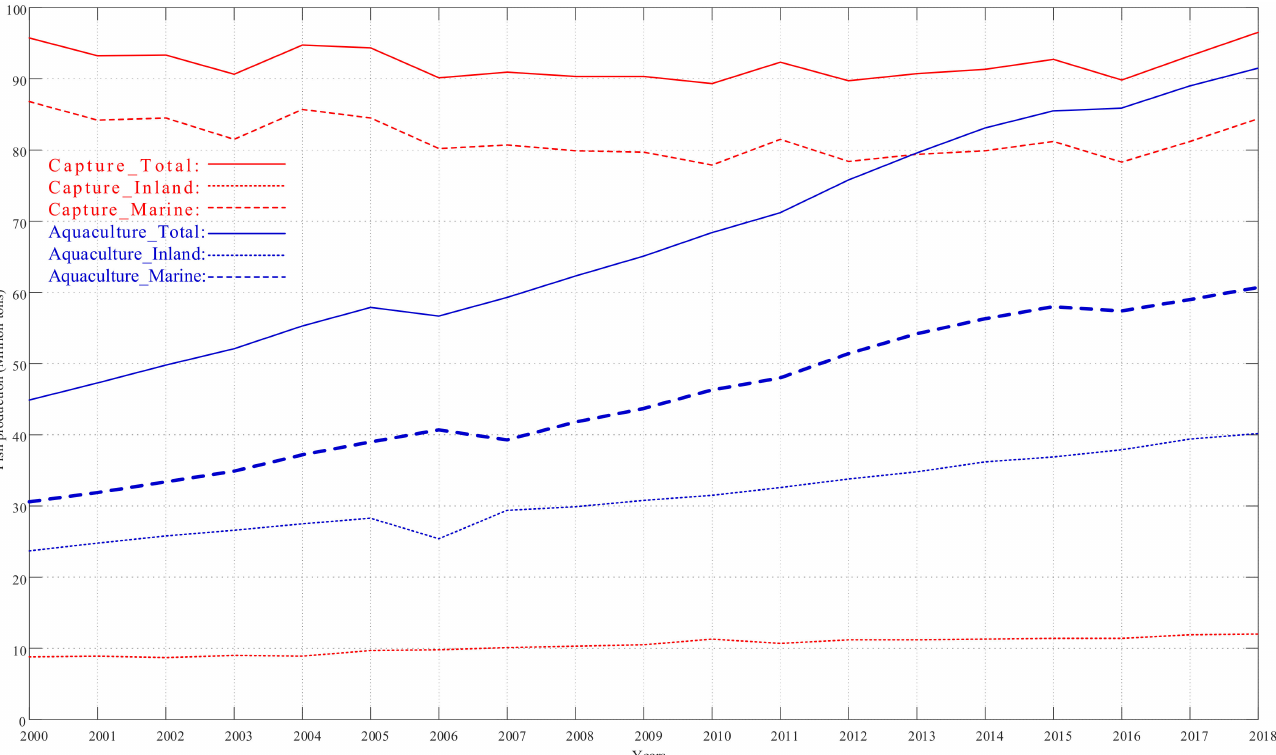
Figure 1. Global fish production of capture fisheries and